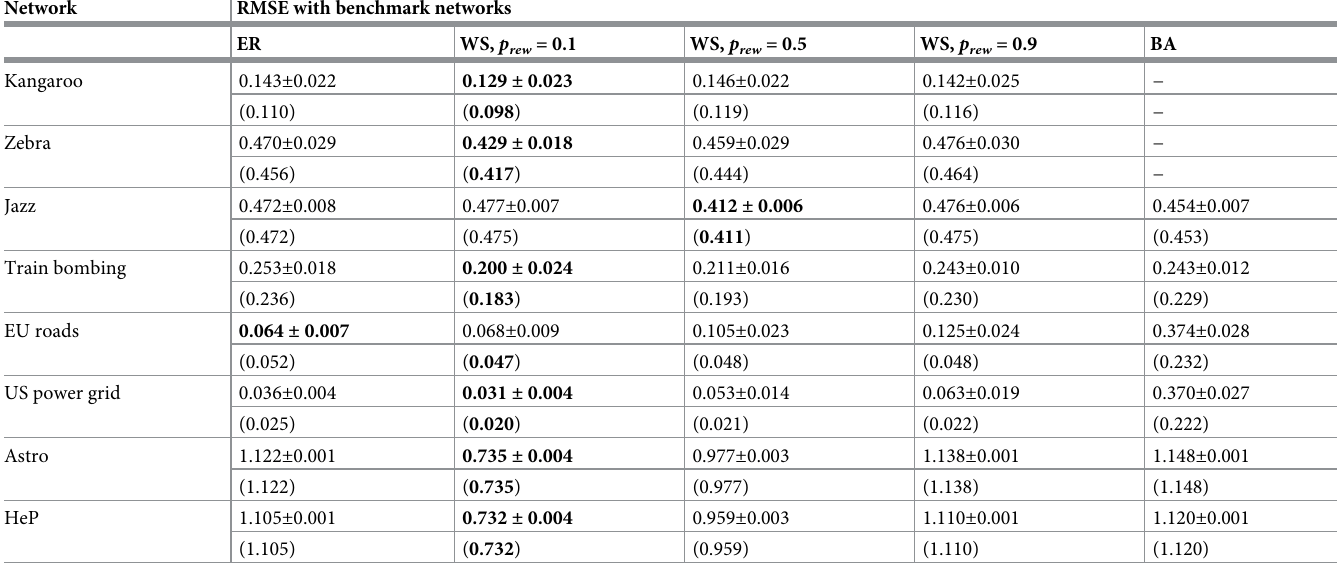
Table 2. Comparison between the reconstructed potentials of real and synthetic networks. For each real network, we consider five different ensembles of synthetic net- works with approximately the same average degree, sampling 100 realizations of each ensemble. We construct a distribution of RMSE between the potentials associated to the real network and to each syntetic network. Mean and standard deviation of each distribution are reported in the table, with network models closest to the real ones highlighted in boldface. The number in brackets represents the RMSE between the real network potential and the ensemble median